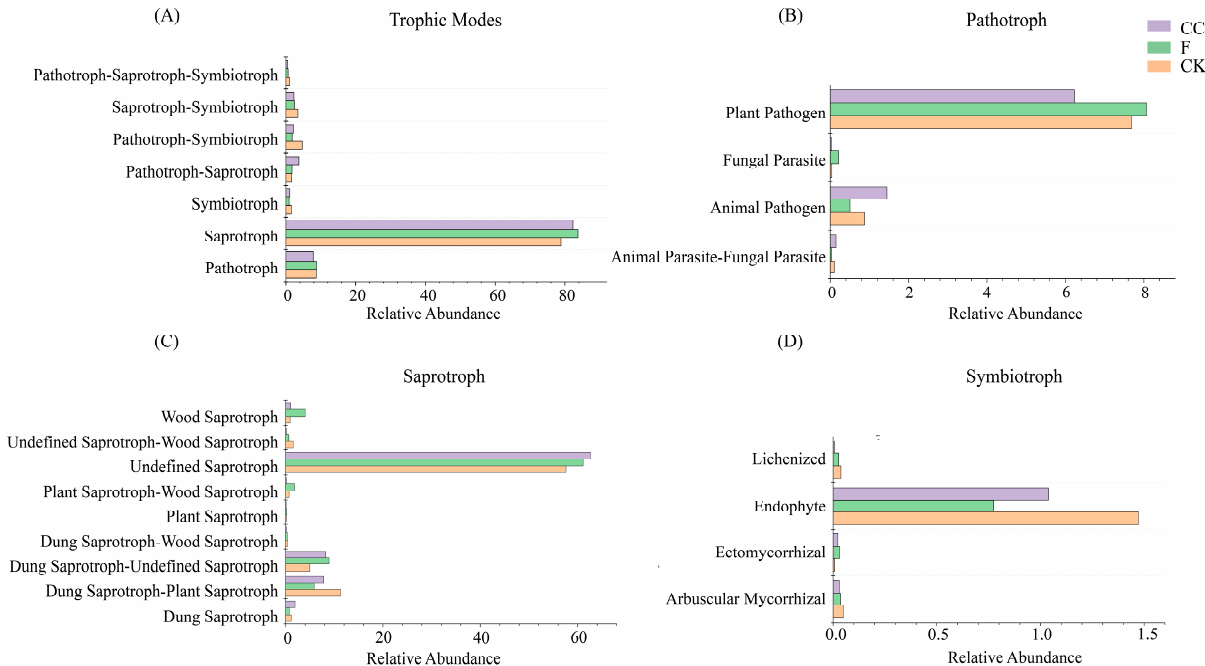
Figure 8. The relative abundance of trophic modes ( A ) and the main guilds ( B – D ) in the soil fungal communities in the three treatments as assigned by FUNGuild.